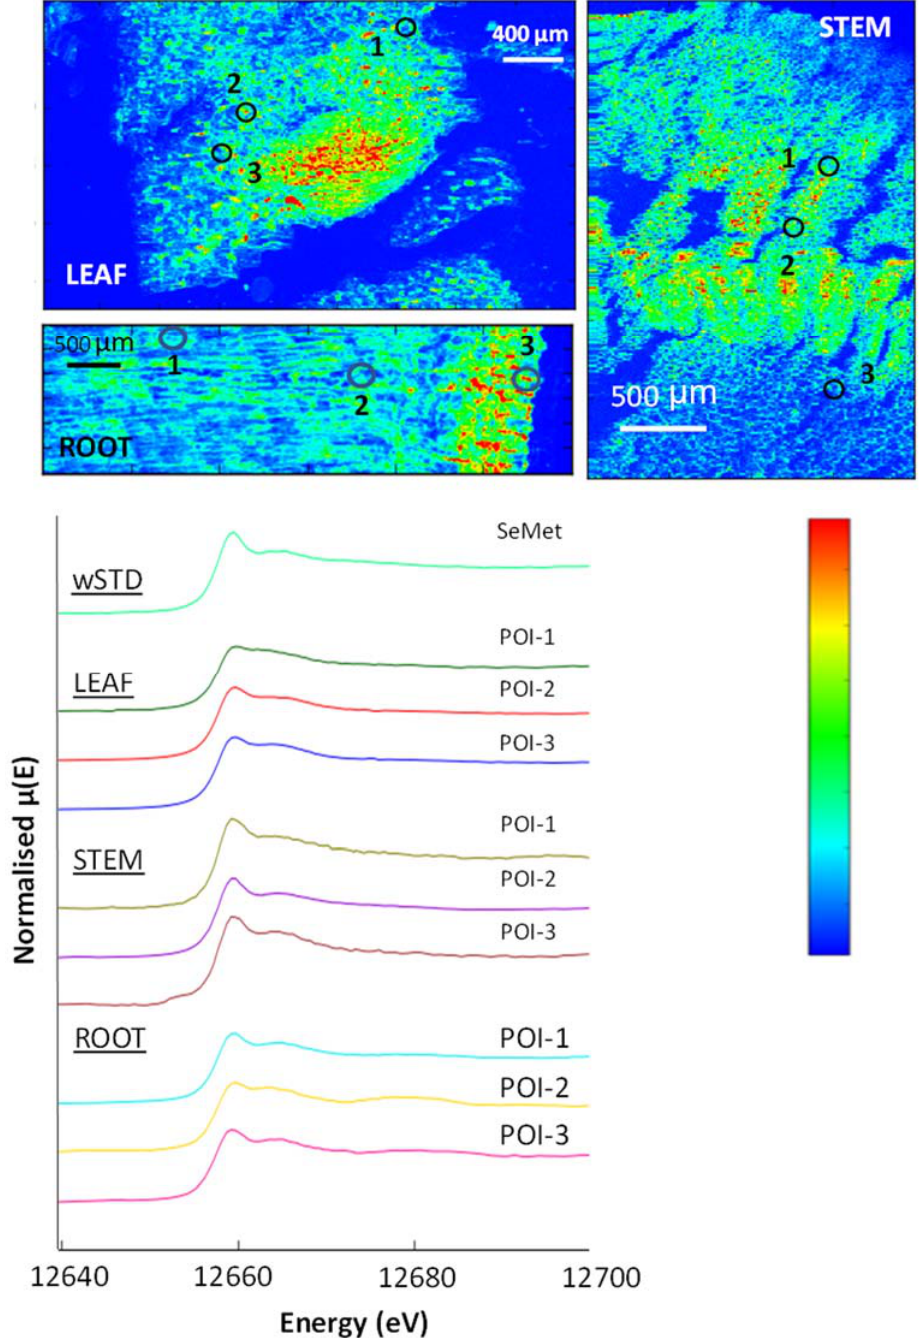
Figure 10. µ -XRF Se K -edge maps showing a hispi cabbage leaf cross-section through a stem and Figure 10. μ ‐ XRF Se K ‐ edge maps showing a hispi cabbage leaf cross ‐ section through a stem and root ( top ). The µ -XRF is on a temperature scale, with high selenium counts in red and areas with root ( top ). The μ‐ XRF is on a temperature scale, with high selenium counts in red and areas with no no counts in dark blue. ( Bottom ): normalised XANES spectra showing selenium species in selected counts in dark blue. Bottom: normalised XANES spectra showing selenium species in selected POIs and the SeMet standard. POIs and the SeMet